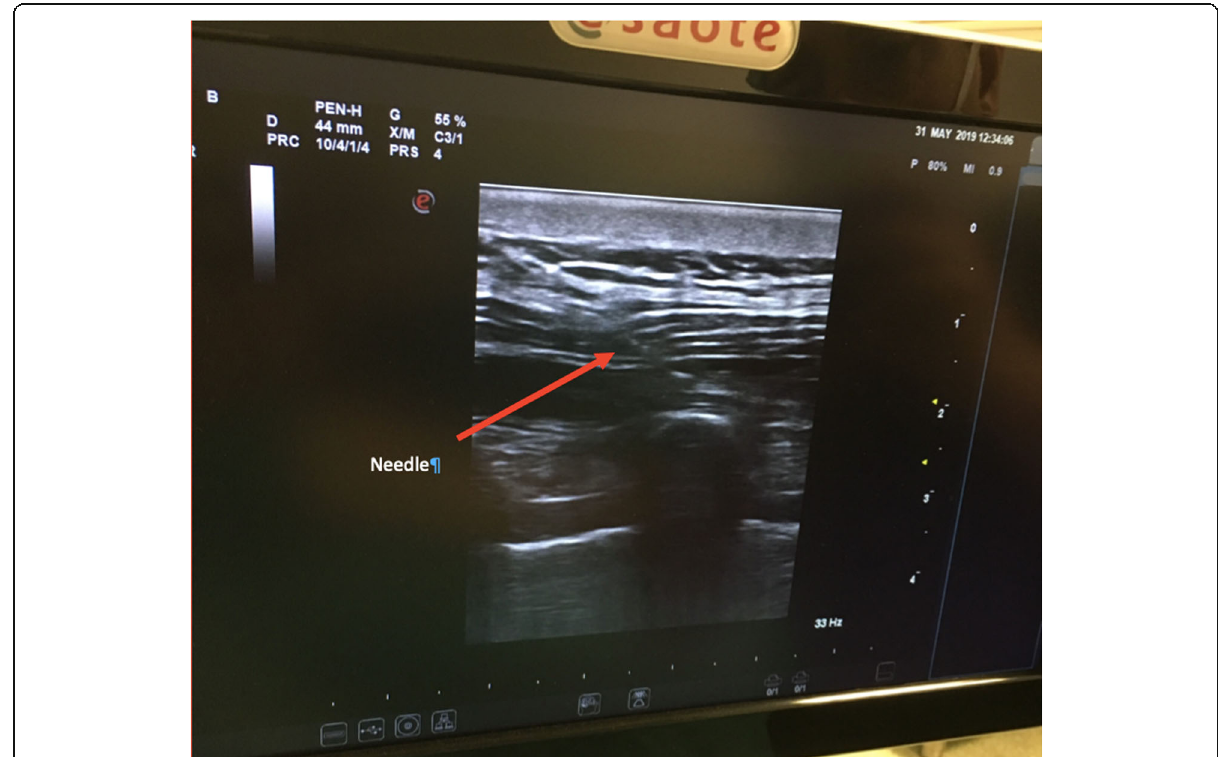
Fig. 1 Advancing of needle to the T5 transverse